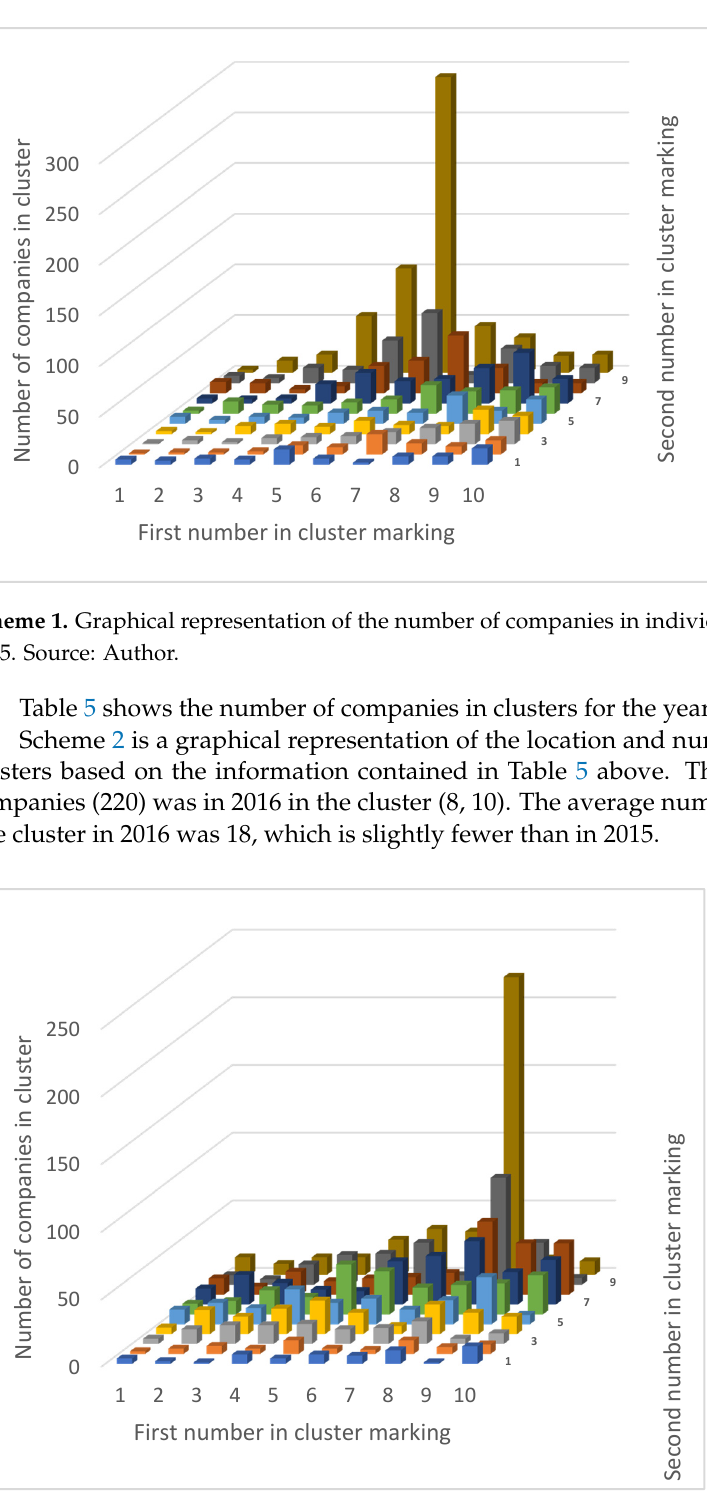
Table 5. The number of companies in individual clusters for the year